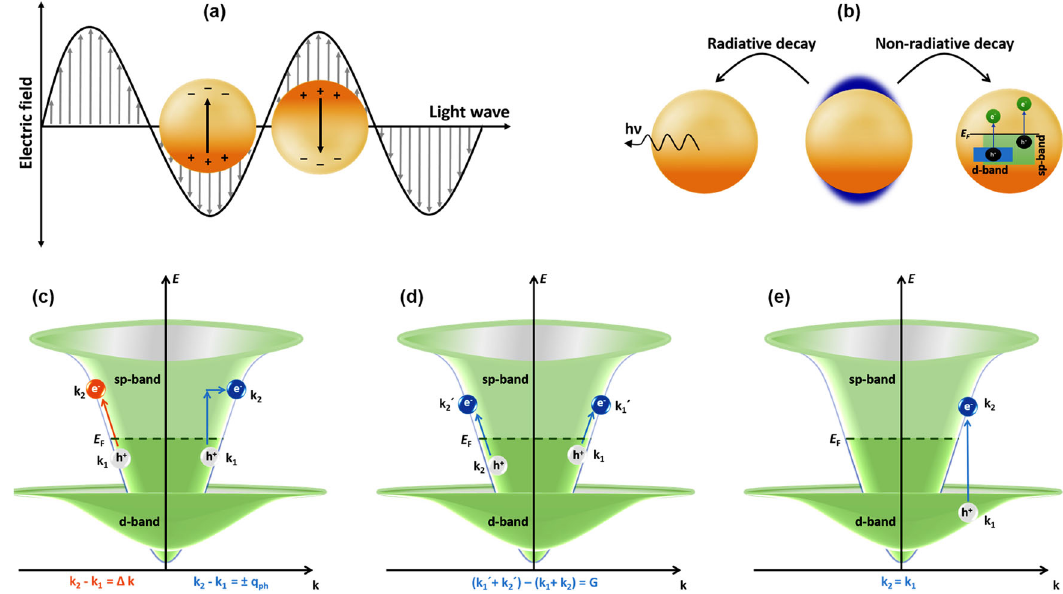
Fig. 1 Plasmon excitation and decay through electronic excitation. a Interaction of electromagnetic radiation with plasmonic metal nanoparticle and LSPR excitation. b The dissipation of high local electric fi elds near the surface of the metal nanoparticles via radiative or non-radiative decay. c Indirect, intraband s- to- s , phonon-assisted (blue arrow) and surface collision-assisted “ diagonal ” transitions (orange arrow). d Indirect, intraband s- to- s , electron – electron scattering-assisted transition where the momentum is conserved via the Umklapp process. e Direct, interband d -to- s transition (adapted from ref. 10